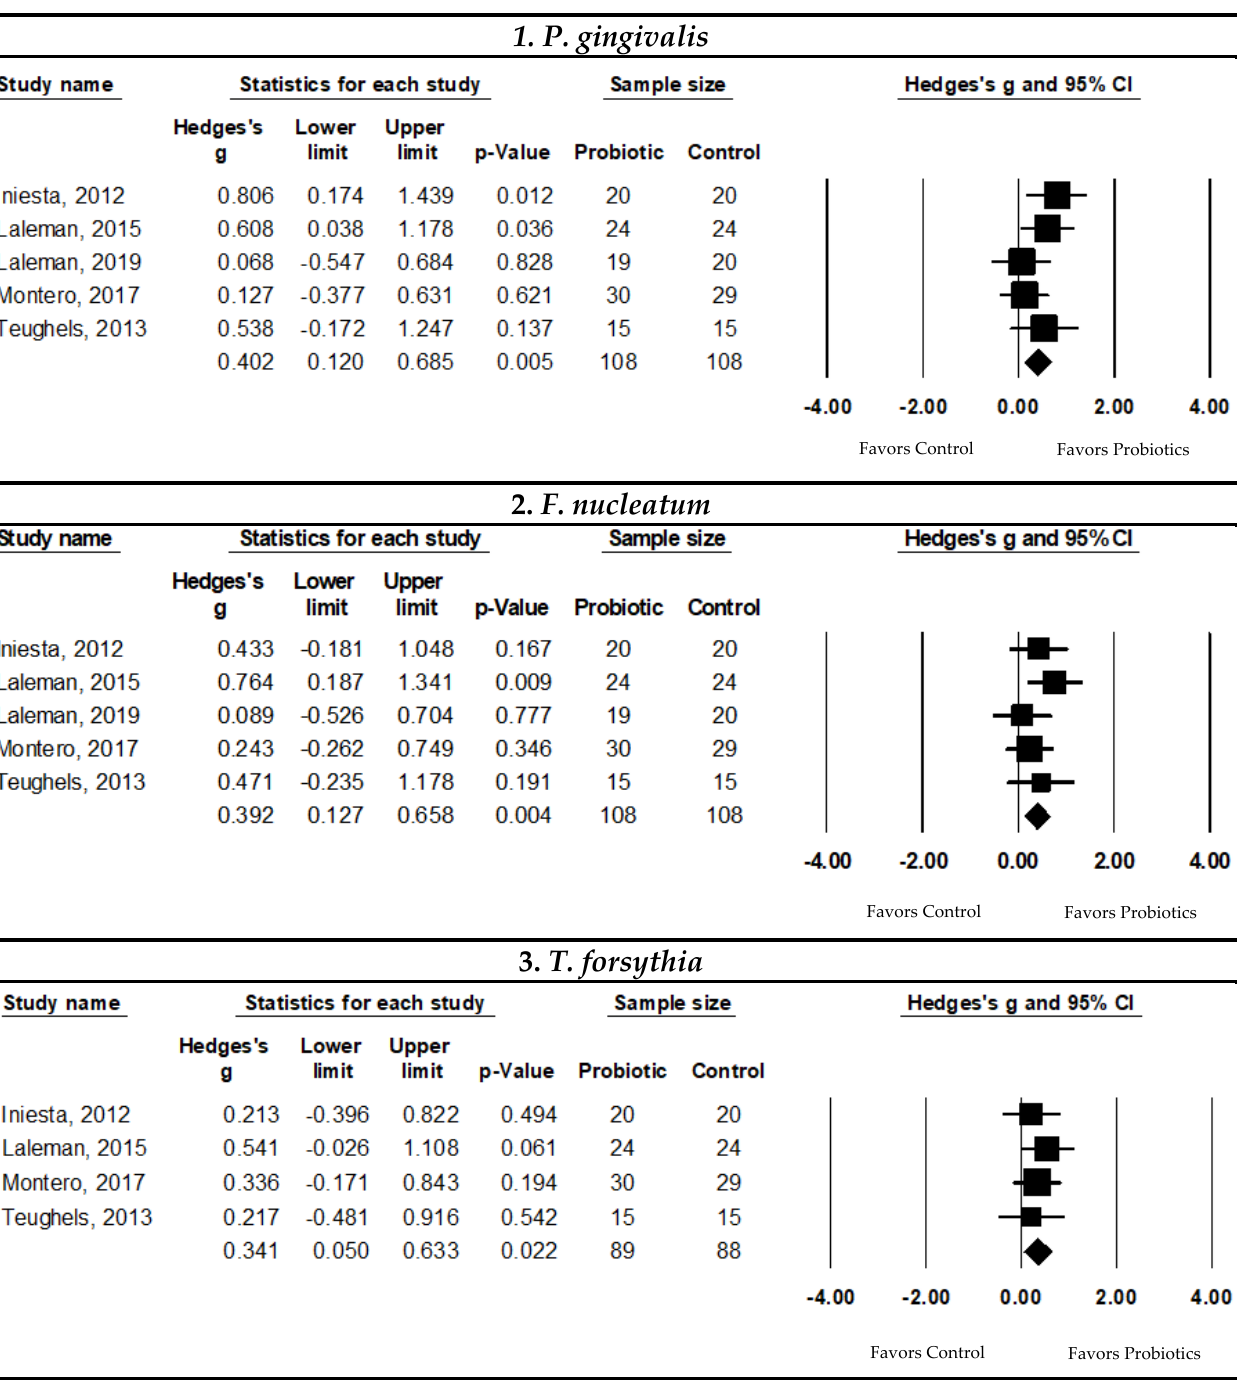
Figure 4. Pooled meta-analysis examining the effects of probiotic supplementation on microbiological outcomes in periodontal disease patients. 1. Forest plot of the Hedge’s g SMD comparing the effects of probiotic supplementation to control groups on the subgingival P. gingivalis bacterial count using a random-effects model [14,43,76,77,102]. 2. Forest plot of the Hedge’s g SMD comparing the effects of probiotic supplementation to control groups on the subgingival F. nucleatum bacterial count using a random-effects model [14,43,76,77,102]. 3. Forest plot of the Hedge’s g SMD comparing the effects of probiotic supplementation to control groups on the subgingival T. forsythia bacterial count using a random-effects model